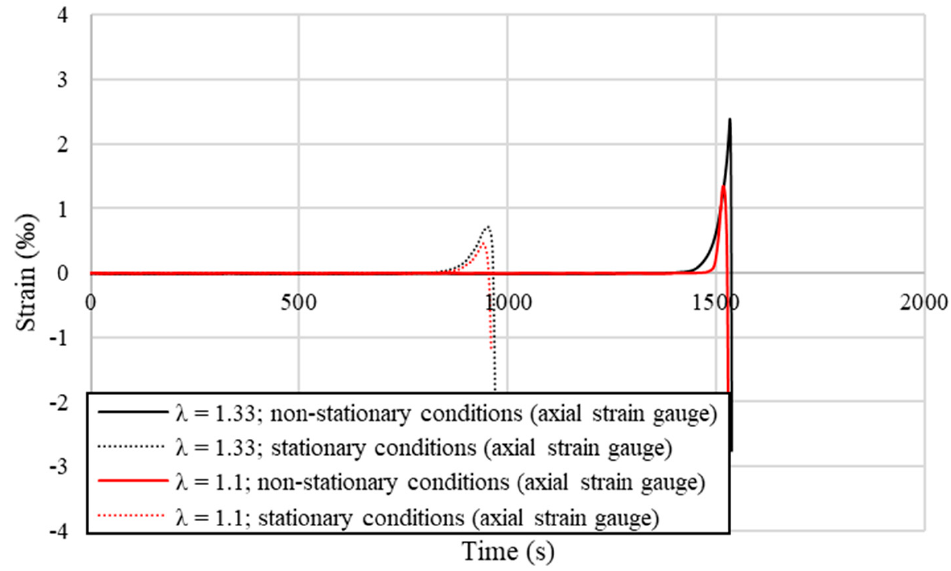
Figure 11. Strain gauge measurements of the elastic deformation in the axial direction (representative